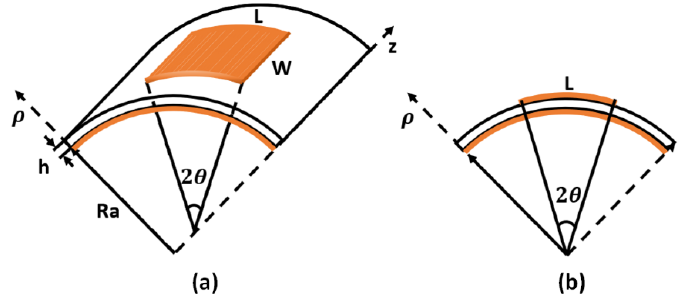
Figure 1. On the cylindrical surface, a rectangular patch antenna is curved along the E-plane: ( a ) geometric model and ( b ) main view.